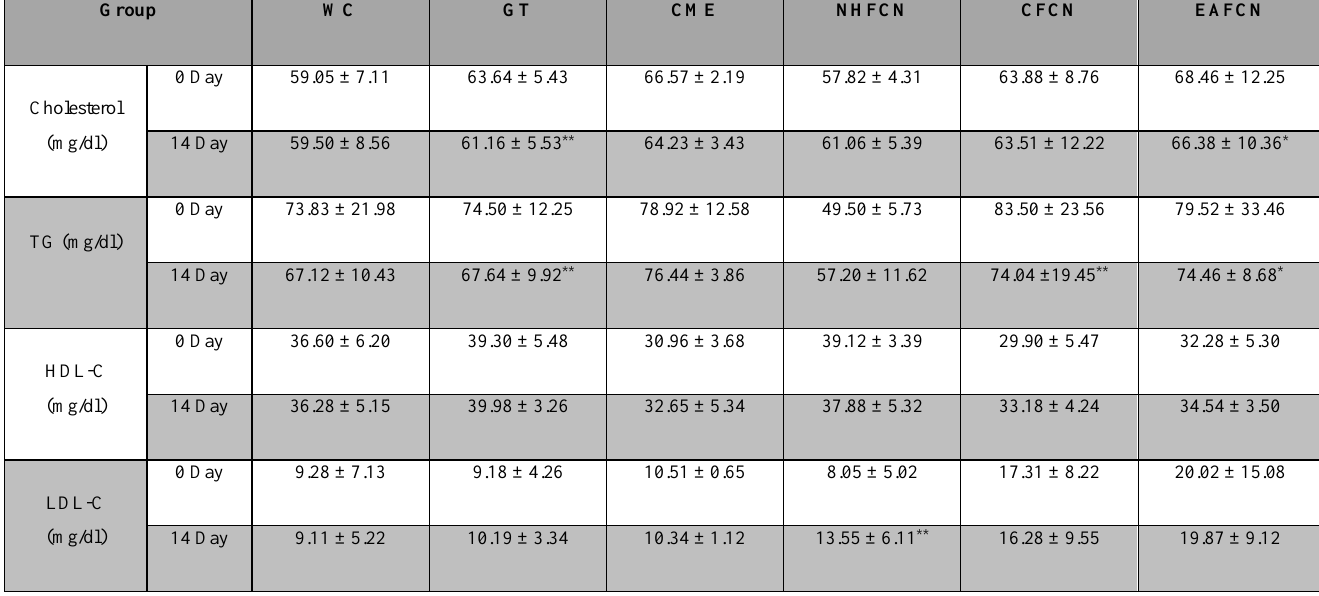
Table 2. Effects of Cocos Nucifera extracts on fasting serum insulin, total serum cholesterol, triglyceride, HDL, and an LDL level of type II diabetic rats.